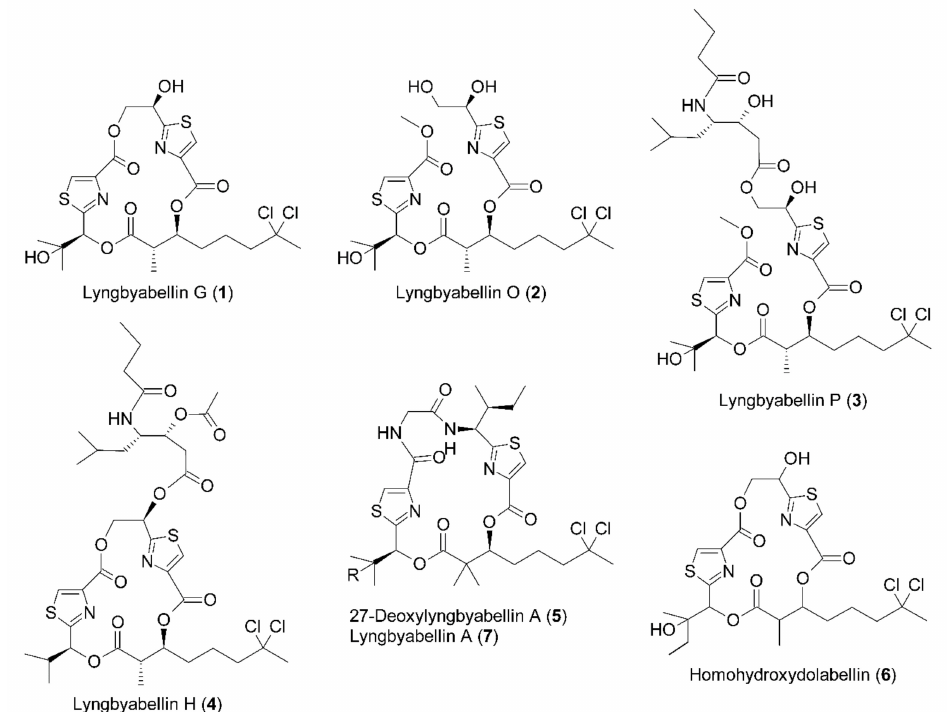
Figure 1. Structure of depsipeptides isolated for this study: lyngbyabellin G ( 1 ), lyngbyabellin O ( 2 ), lyngbyabellin P ( 3 ), lyngbyabellin H ( 4 ), 27-deoxylyngbyabellin A, R = H ( 5 ), homohydroxydolabellin ( 6 ), and lyngbyabellin A, R = OH ( 7 ). Compounds 1 – 5 are from Okeania sp. and 6 – 7 from M. bouillonii